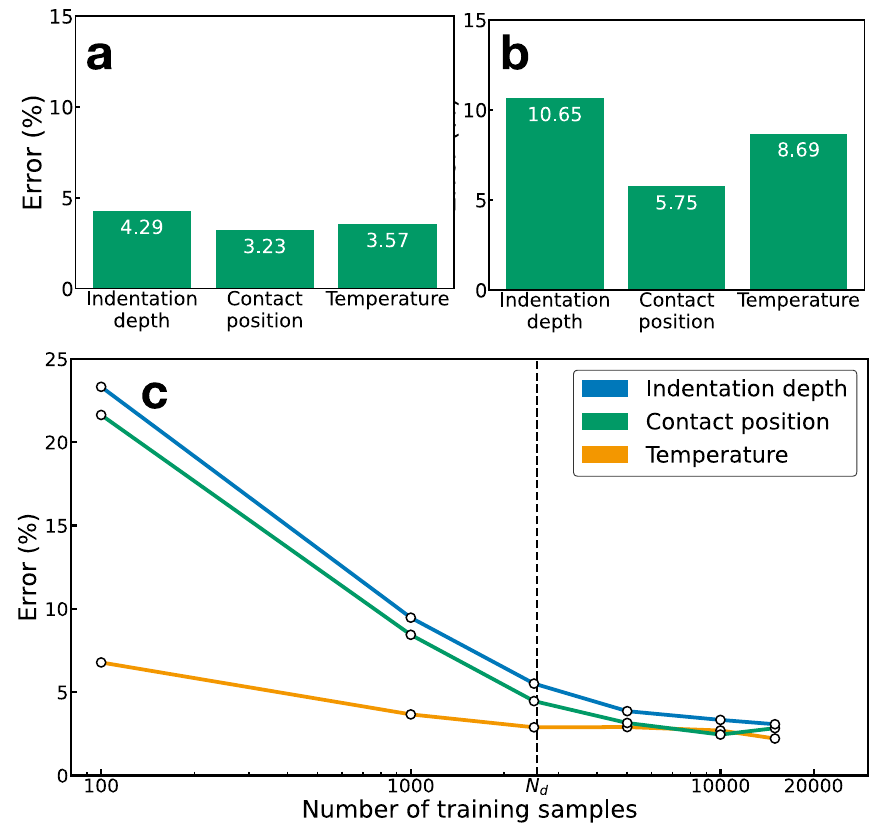
Figure 5. Effects of training data collection. Estimation errors for (a) C (� x 1 ) ≈ 0.61 and C (� x 2 ) ≈ 0.66 and (b) C (� x 1 ) ≈ 0.42 and C (� x 2 ) ≈ 0.36 . The estimation errors depend on the sampling intervals (cid:31) x i (and the correlation C (� x i ) between the sampled speckle patterns). The estimation errors tend to be lower for smaller sampling intervals and higher correlations. (c) Estimation errors as a function of the number of training